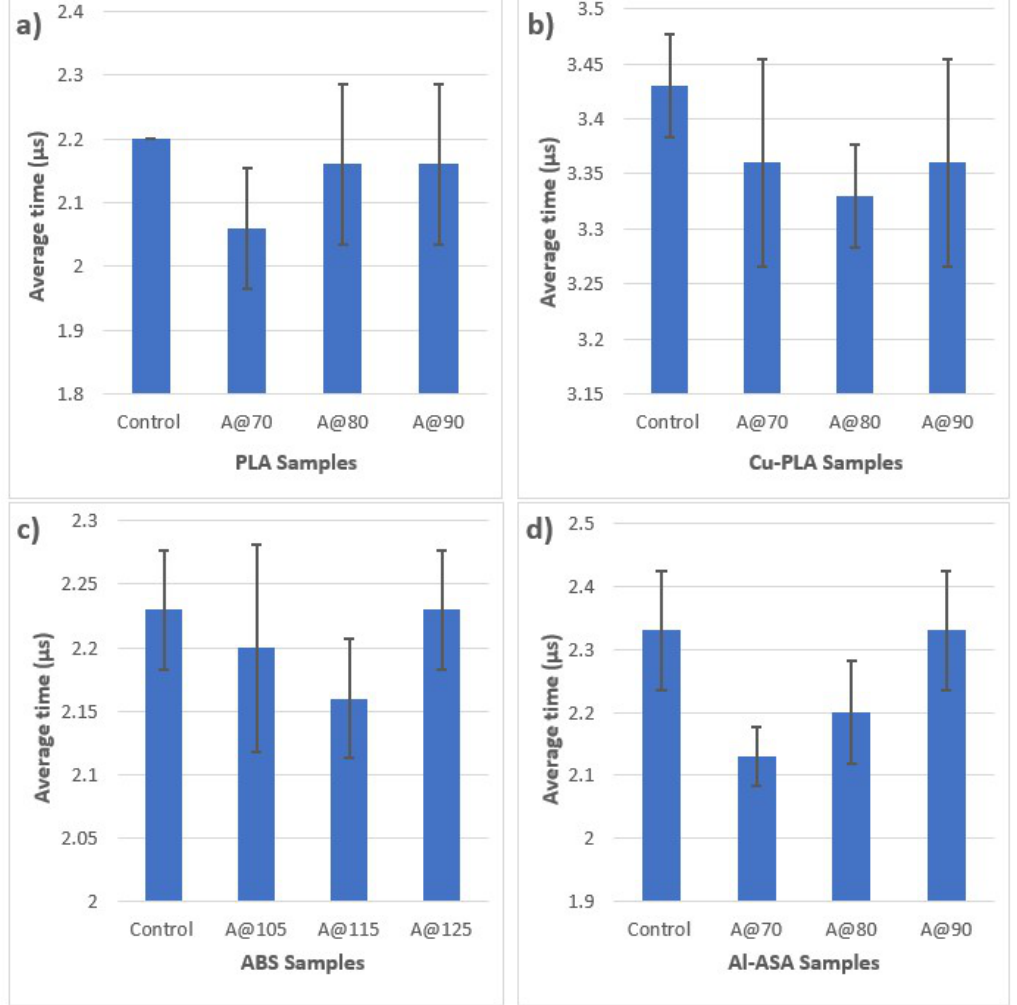
Figure 9. Results from ultrasonic testing: ( a ) PLA material; ( b ) Cu-PLA material; ( c ) ABS material; ( d ) Al-ASA material.